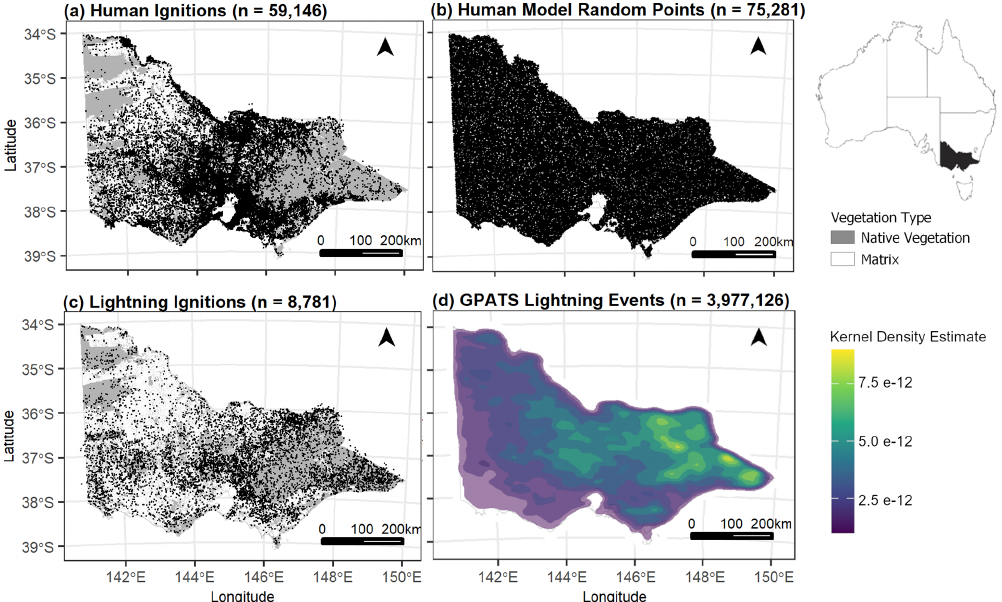
Figure 1. Study area showing the distribution of (a) recorded human ignitions (presence data) in remnant native vegetation and areas of cleared or modified (i.e. matrix) vegetation (from the Country Fire Authority [CFA] and Department of Land, Water and Planning [DELWP] ignitions data), (b) randomly generated points (human ignitions absence data), (c) recorded lightning ignitions in native and matrix vege- tation (from CFA and DELWP ignitions data), and (d) a kernel density estimate for all lightning strikes detected in Victoria for the study period (from the Global Position and Tracking System Pty Ltd dataset). Native vegetation and matrix layers sourced from: Department of Environment, Land, Water and Planning (2017, https://www.data.vic.gov.au/, last access: 13 November